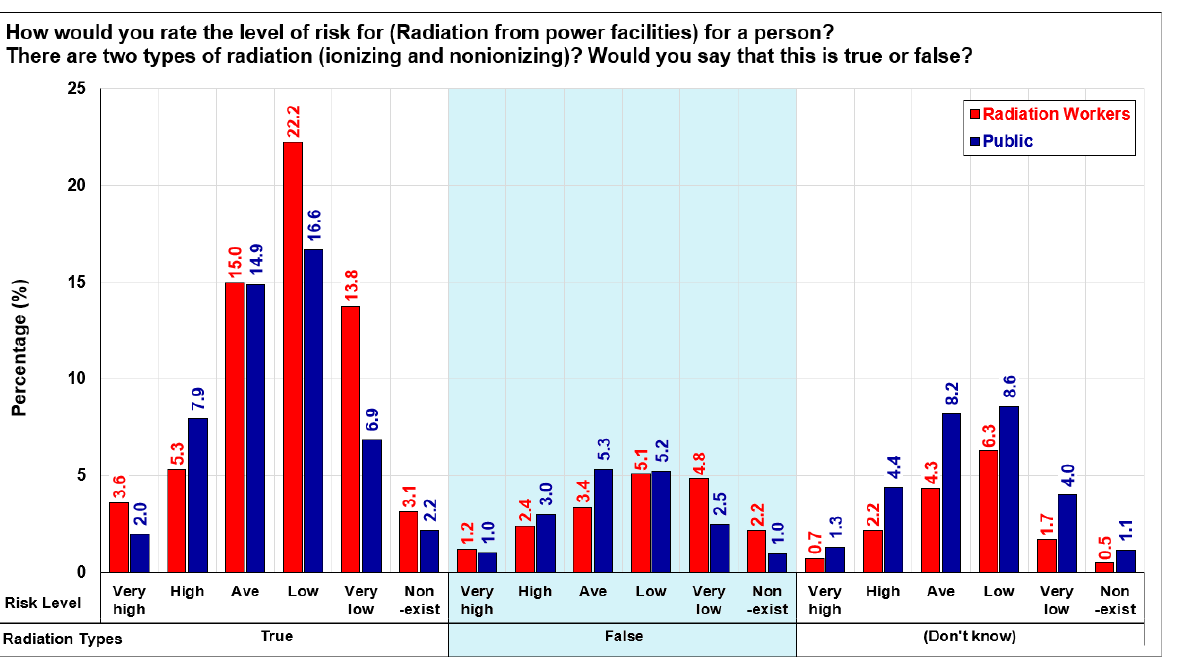
Figure 3. Radiation workers and public ranking of the level of risk radiation from power facilities and correct answer regarding two types of radiation.